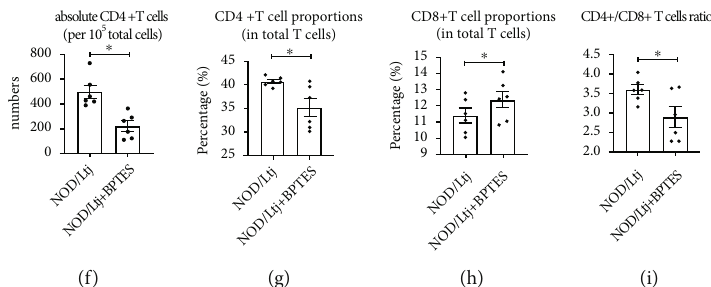
Figure 4: Treatment with BPTES alleviated the symptoms of SS and CD4+ T cell proportions in NOD/Ltj mice. (a) Simulated salivary fl ow rate of NOD/Ltj mice and wild-type ICR mice treated with the indicated doses of BPTES. The salivary fl ow rate was measured at the ages of 8 weeks, 10 weeks, and 12 weeks. (b) Pictures of H&E staining in NOD/Ltj mice treated with/without 10 mg/kg BPTES. (c) Pictures of immunohistochemical staining of CD4 in NOD/Ltj mice treated with/without 10 mg/kg BPTES. (d) Pictures of immunohistochemical staining of PCNA in NOD/Ltj mice treated with/without BPTES. (e) Representative picture of fl ow cytometry in salivary glands of the indicated NOD/Ltj mice. The proportions of CD4+ T cells (CD3+CD4+CD45+) and CD8+ T cells (CD3+CD8+CD45+) were gated and evaluated. (f) Measurement of the absolute CD4+ T cell numbers in NOD/Ltj mice treated with/without BPTES. (g) Measurement of the percentage of CD4+ T cells in total T cell populations in NOD/Ltj mice treated with/without BPTES. (h) Measurement of the percentage of CD8+ T cells in total T cell populations in NOD/Ltj mice treated with/without BPTES. (i) Measurement of CD4+/CD8+ T cell ratios in NOD/Ltj mice treated with/without BPTES. Summary data are presented as ∗ p < 0 : 05 with unpaired two-tailed Student ’ s t